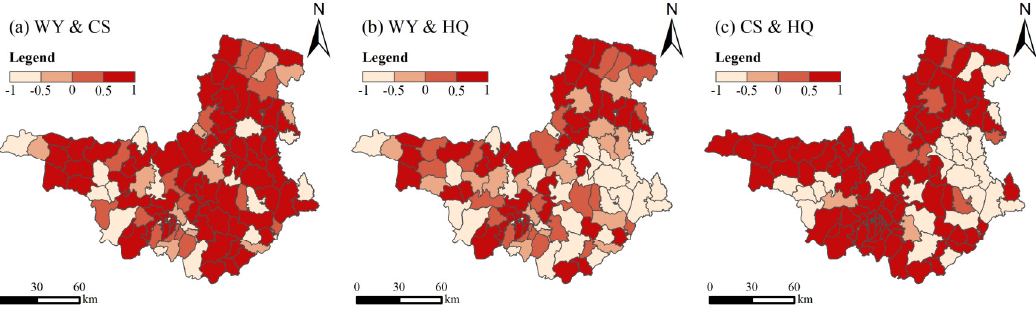
Figure 6. Tradeoffs and synergistic relationships of ecosystem services in the Danjiangkou reservoir area.